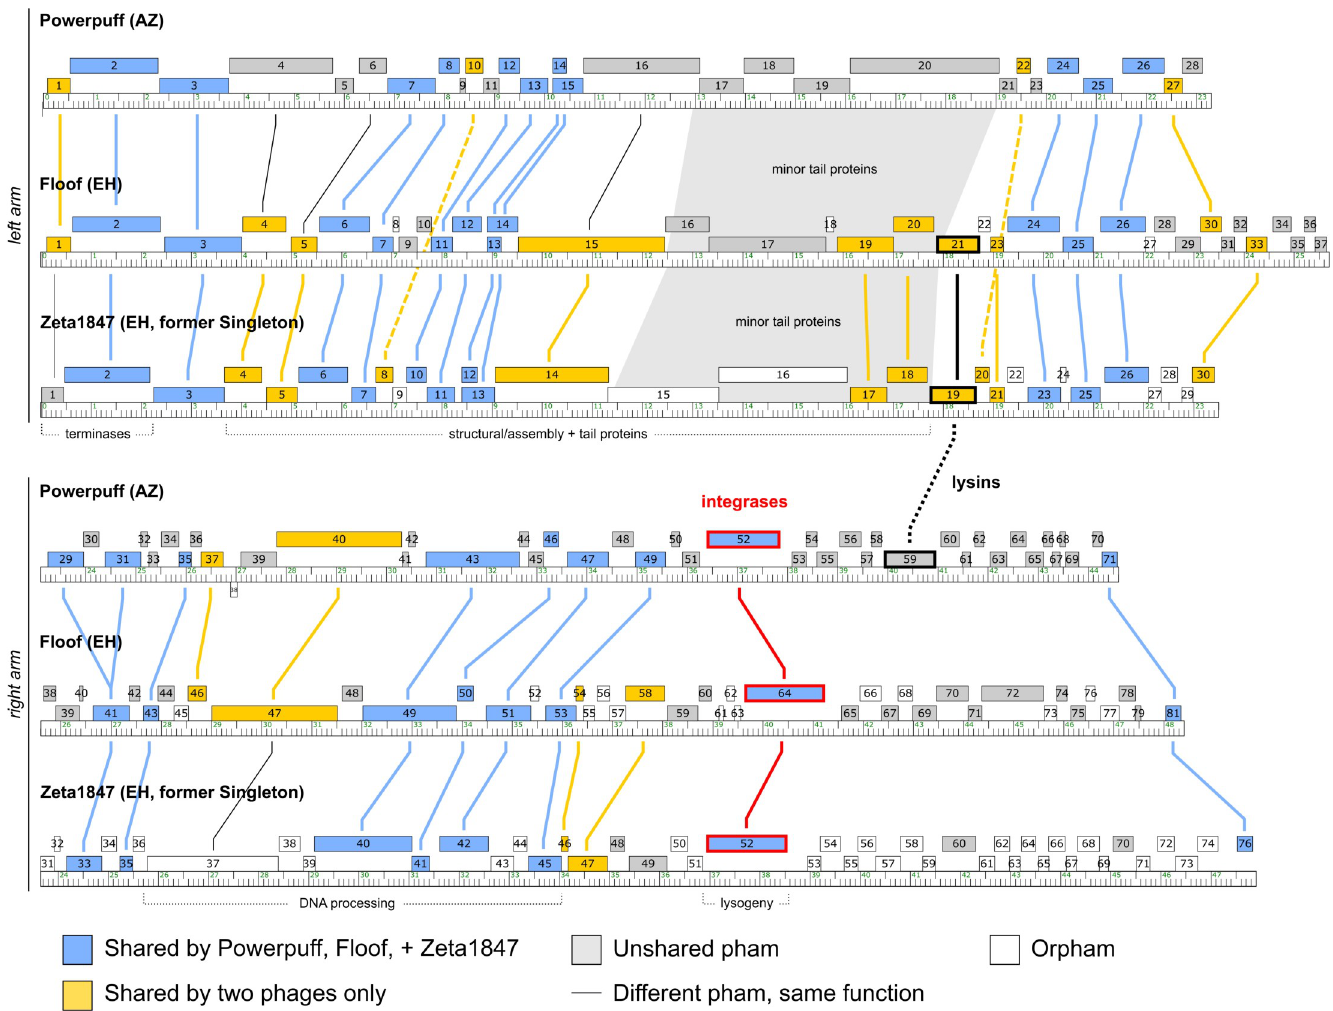
Fig 6. Clusters AZ and EH phages share similar genome architectures. Genome maps were downloaded from Phamerator and formatted using Inkscape 1.0. Genes in different phams with conserved functions are indicated by thin black lines and shaded regions. Integrases are highlighted in red, while lysins are highlighted in black. The left arm (top panel) of each genome was highly similar, with a less conserved right arm (bottom panel). Genes belonging to the same phams exhibited a conserved order. In Powerpuff, endolysin was found in the right arm rather than the left arm. Only Cluster AZ phages Elezi, Liebe, and Maureen encode endolysins in the left arm as do the Cluster EH